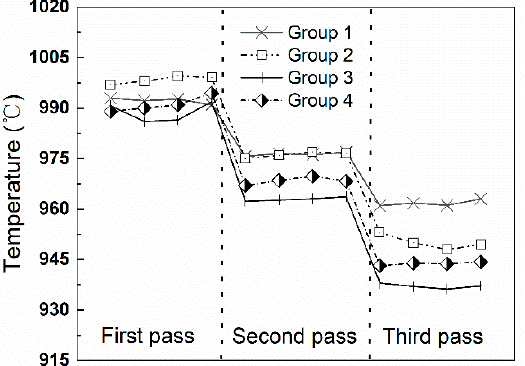
Figure 7. The surface temperature of the rail steel plates varies during the rolling